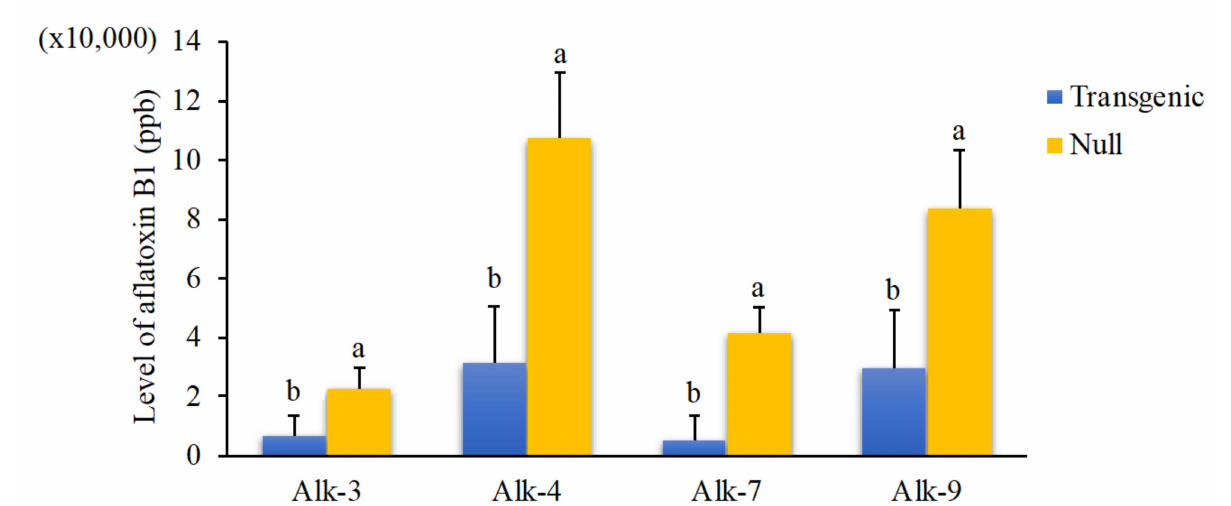
Figure 2. Aflatoxin production in the Alk-RNAi homozygous transgenic and null kernels of Alk-3, Alk-4 Alk-7 and Alk-9 events at T3 generation under in vitro Kernel Screening Assay (KSA) conditions. Analysis was carried out using 20 replicates (one kernel/replicate) each of homozygous and null controls. Bars with different letters are significantly different at p ≤ 0.05. A. flavus inoculum concentration of 4 × 10 6 conidia/mL was used for this